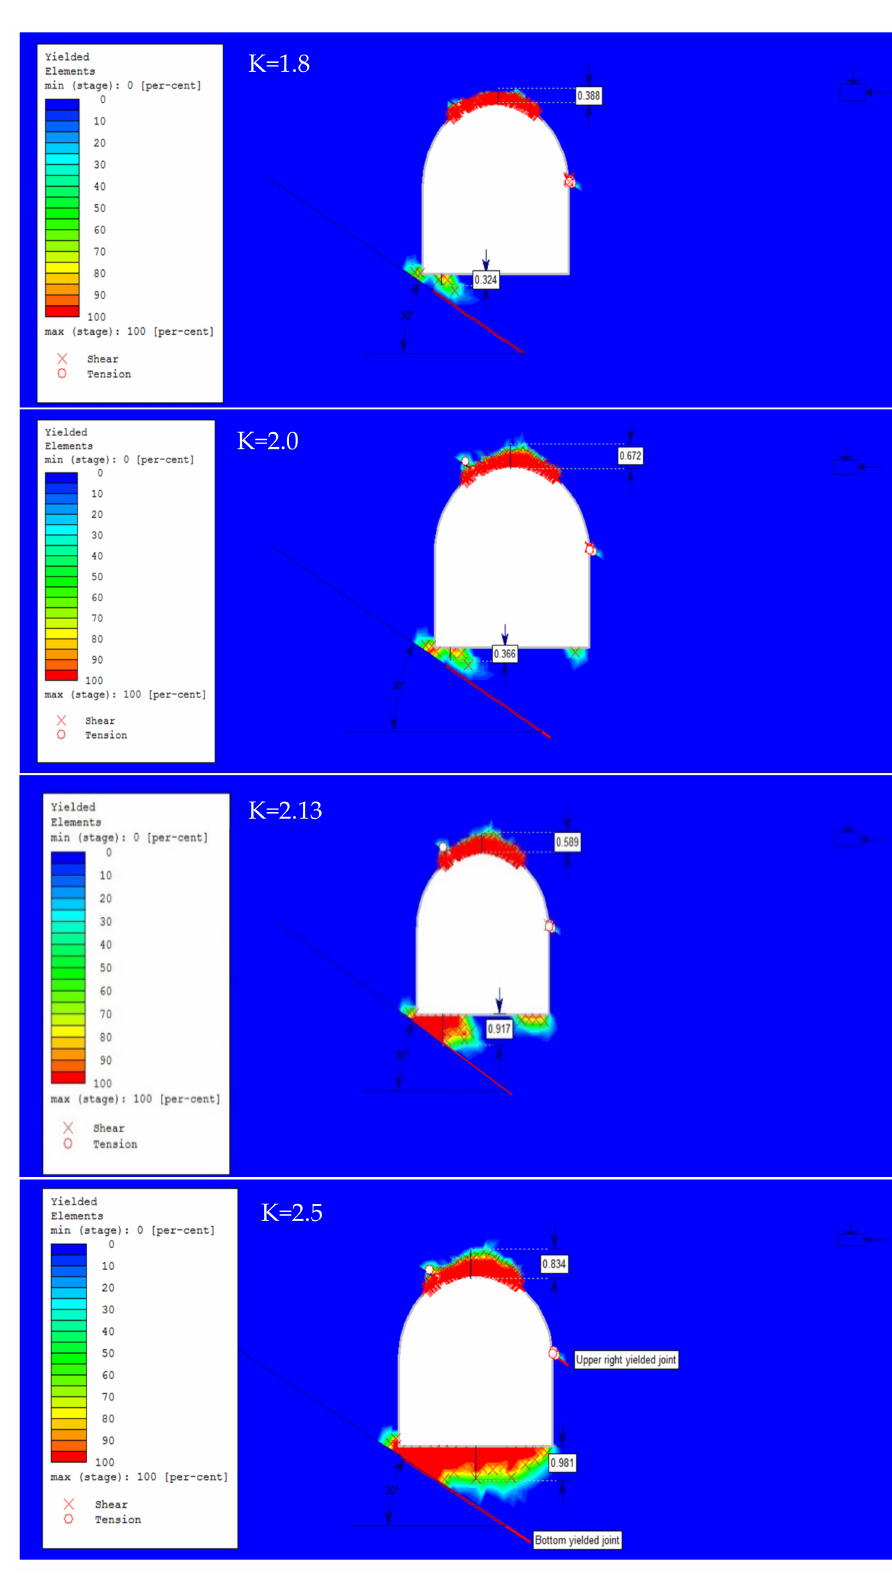
Figure 11. Extent of yielding zones around tunnel opening at various in situ stress ratios